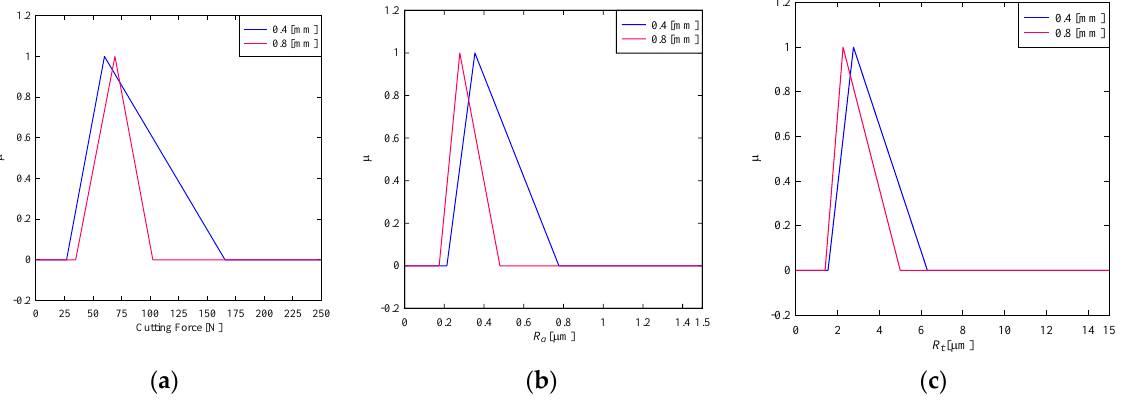
Figure 4. Effect of insert’s nose radius on ( a ) cutting force ( b ) R a ( c ) R t . Thirdly, consider the effect of cutting speed, v c , (m/min). As shown in Figure 5a, both cutting speeds of 40 m/min and 60 m/min minimize cutting force. This means that a cutting speed up to 60 m/min ensures low cutting force. This is not the case for the other cutting speed (80 m/min). As seen in Figure 5b, the surface roughness in terms of R a can be minimized, keeping the cutting speed to 60 m/min. However, the other two cutting speeds also ensure almost the same R a . This means that R a does not depend much on the cutting speed. The same argument is true for R t , as shown in Figure 5c. Apart from the abovementioned qualitative results, the expected values of the cutting force and surface roughness are calculated using the centroid method for quantitative analysis. The results are shown as follows, which is consistent with the abovementioned qualitative analysis. The expected values of cutting force are 63 N, 64.4 N, and 90.13 N for cutting speeds 40 m/min, 60 m/min, and 80 m/min, respectively. The expected values of surface roughness in terms of R a are 0.408 μm, 0.363 μm, and 0.414 μm for cutting speeds 40 m/min, 60 m/min, and 80 m/min, respectively. The expected values of surface roughness in terms of R t are 3 μm, 2.85 μm, and 3.27 μm for cutting speeds 40 m/min, 60 m/min, and 80 m/min, respectively.